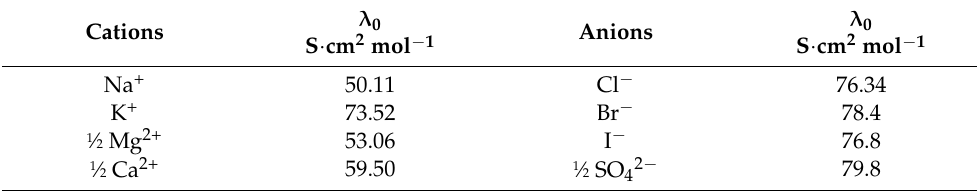
Table 2. Molar ionic conductivities at infinite dilution at 298 K; data from